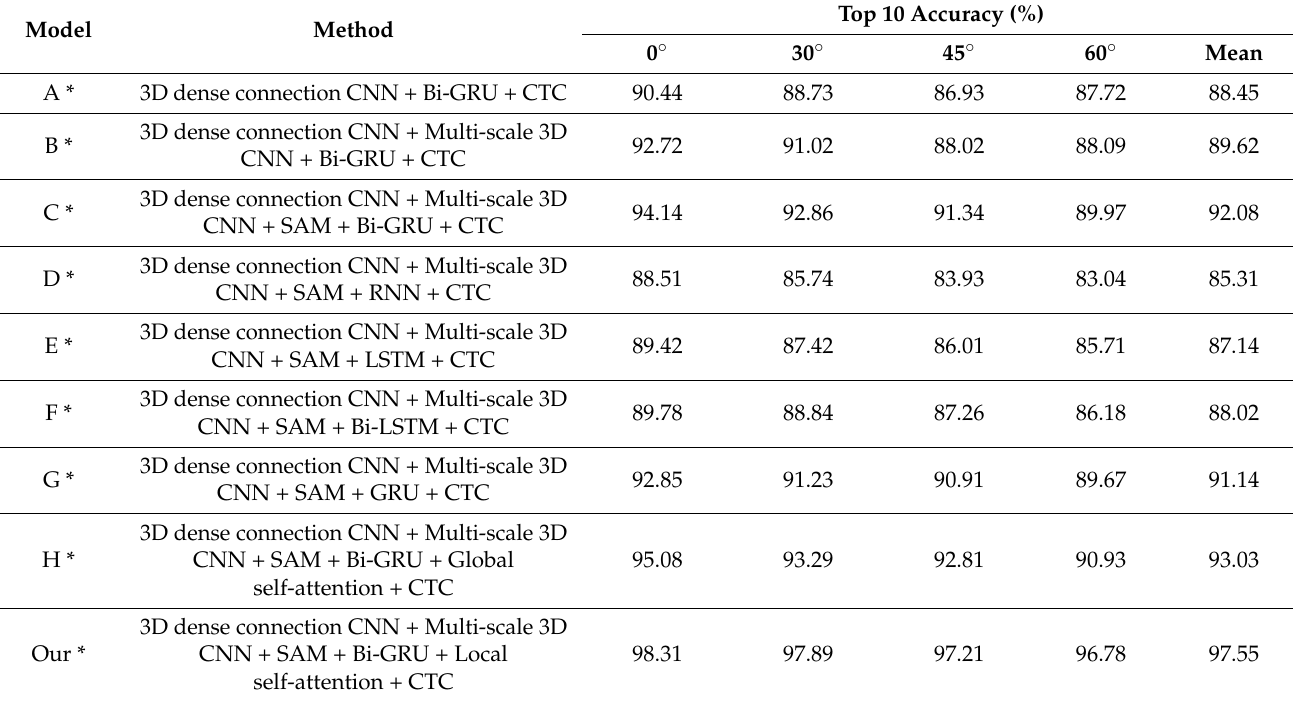
* Model trained with data